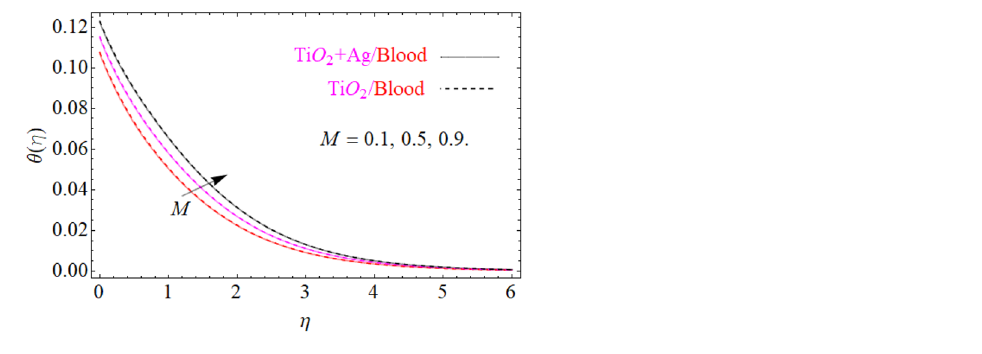
Figure 10. Under the influence of M (Magnetic parameter), θ(η) .